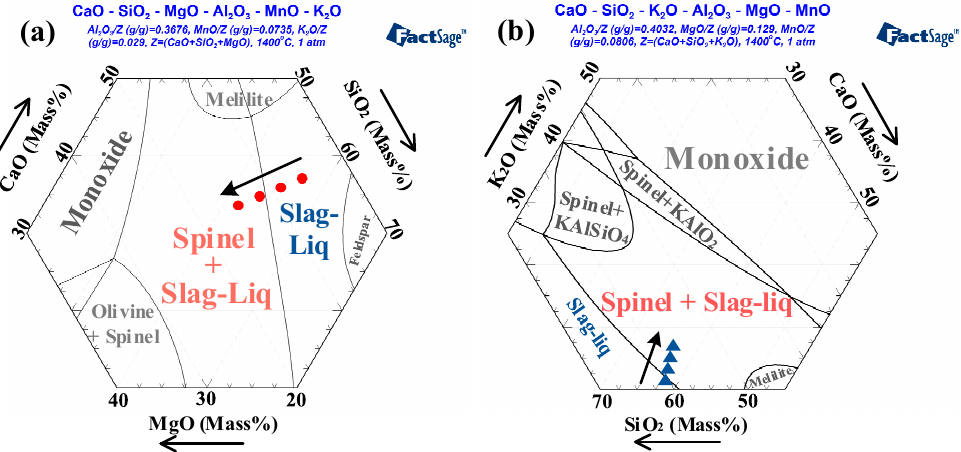
Figure 11. Phase diagram of SiO 2 –CaO–Al 2 O 3 –MnO–MgO–K 2 O slag system at 1400 °C: ( a ) with a varying MgO content; ( b ) with a varying K 2 O content.